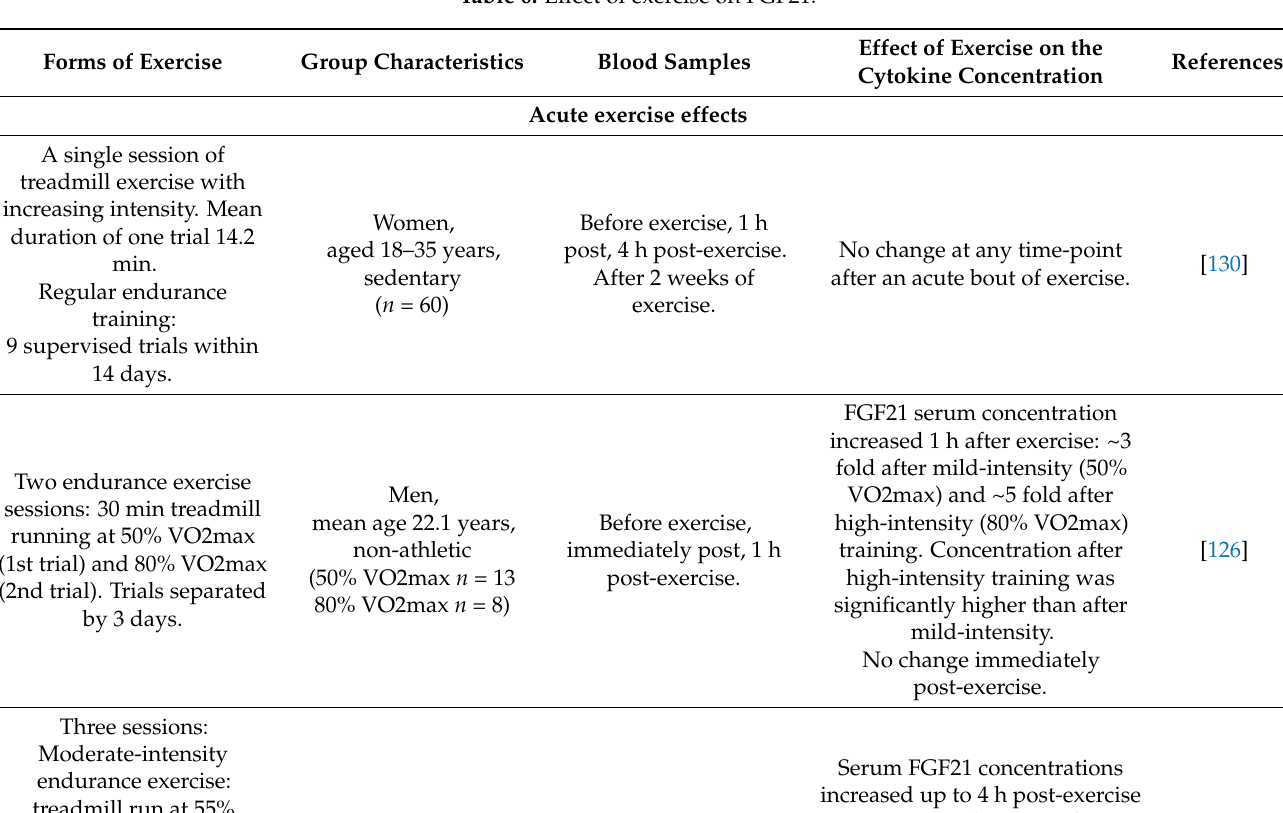
Table 6. Effect of exercise on